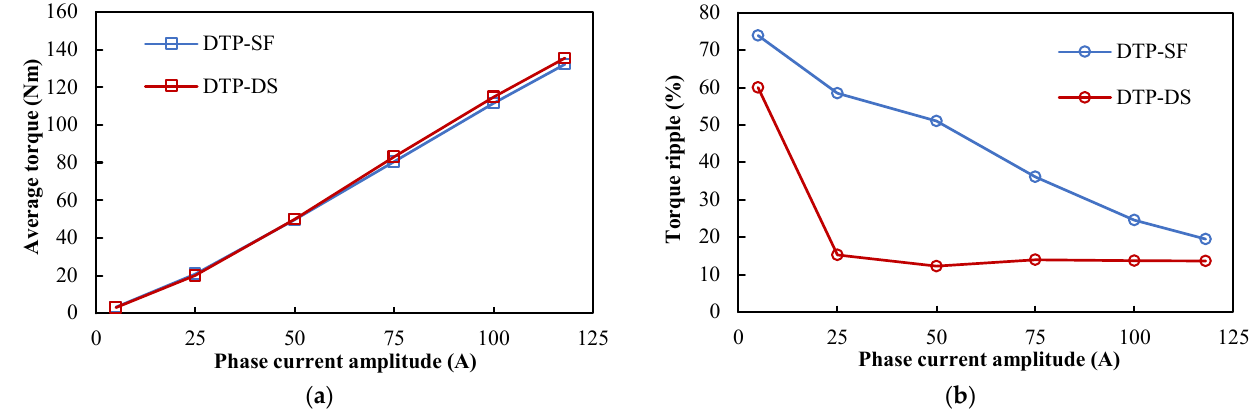
Figure 38. Torque-current amplitude characteristics of different winding configurations with MTPA strategy under the three-phase OC condition: ( a ) average torque; ( b ) torque ripple.